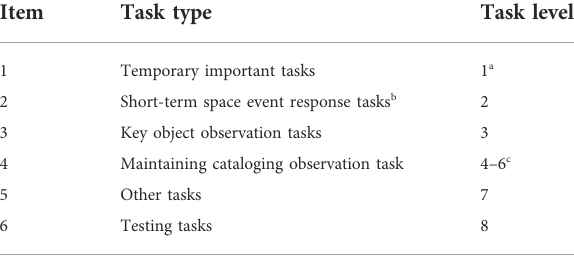
TABLE 1 De fi nition of task-level under different